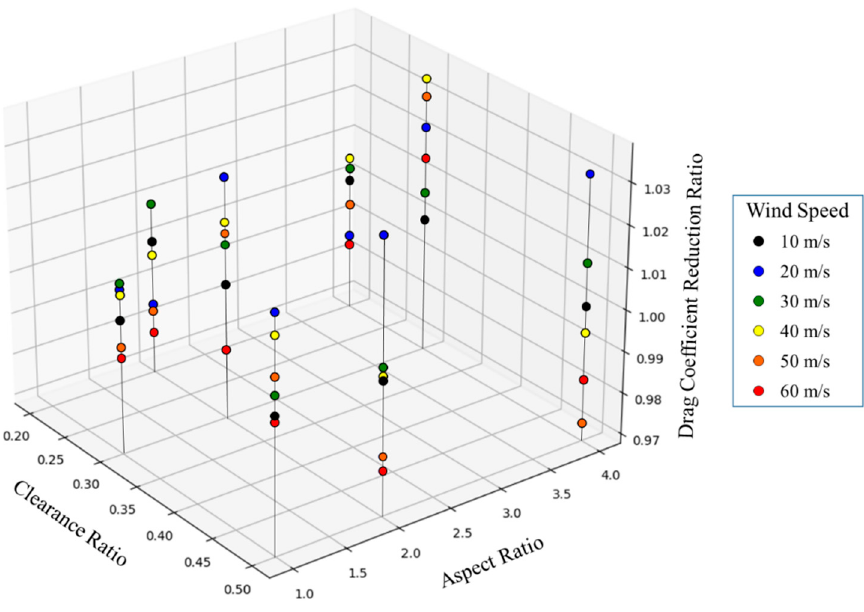
Figure 13. Drag coefficient reduction ratio of perforated road sign by wind speed.